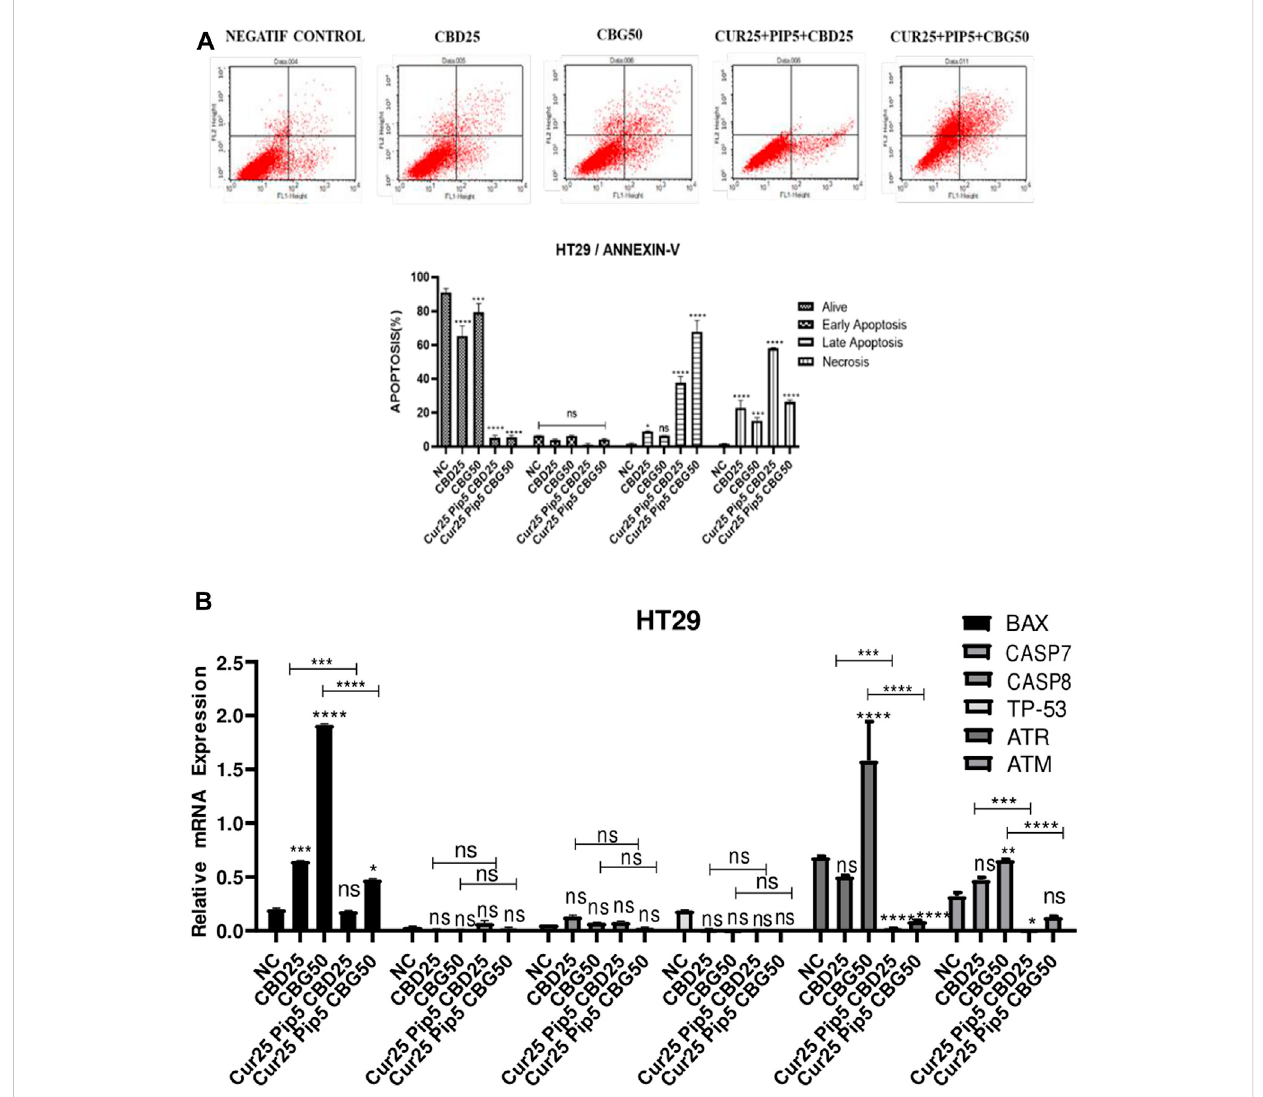
FIGURE 4 (A) Representative Annexin V-FITC/PI staining results for HT29 cancer cells at 72 h quantitative analysis and their values are mean ± SD of three independent experiments (B) Representative graph anti-apoptotic genes expression pro fi les of HT29 cells after 72 h. (ns: non-signi fi cant, *: p < 0.05,